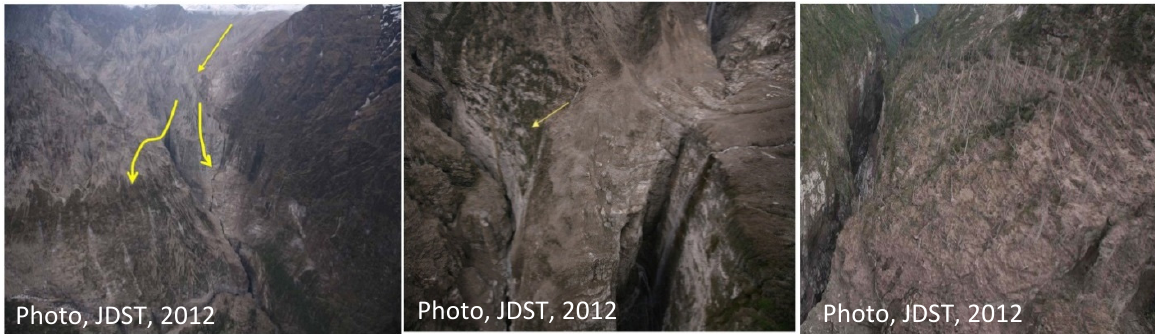
Photo, JDST, 2012